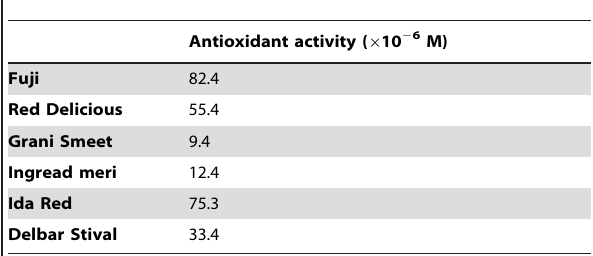
Table 3. Antioxidant activity assay results for extracted solution of various varieties of apple fruit in optimum extraction